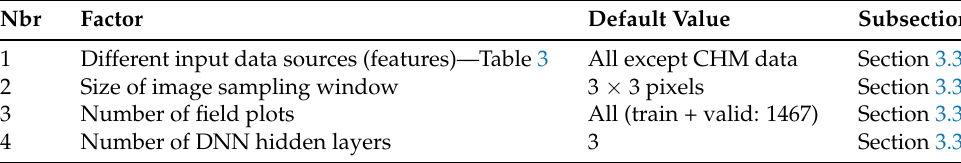
Table 5. Different factors studied for the performance of the deep neural network model. These factors are listed here together with the parameter default values. Refer to the corresponding subsection for more details on test